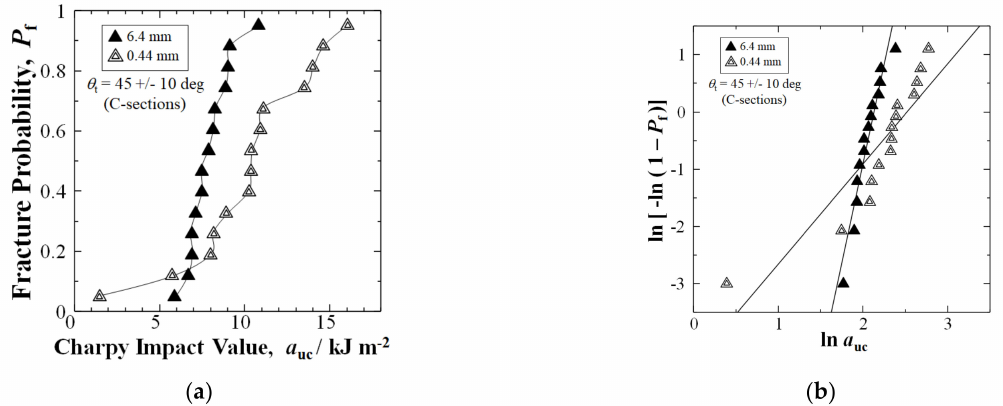
Figure 8. ( a ) Relationships between a uc and P f for nominal 6.4 mm and extended mixed 0.44 mm fiber samples, respectively, for C-Sections with θ t of 45 +/ − 10 deg between mold flow and longitudinal direction of testing sample; ( b ) Weibull 2-parameter plots of data in ( a